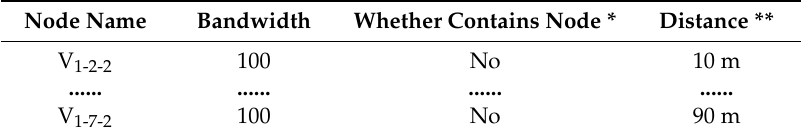
Figure 10. The bandwidth range of fire point p. Table 2. All nodes attributes of fire point p within the bandwidth